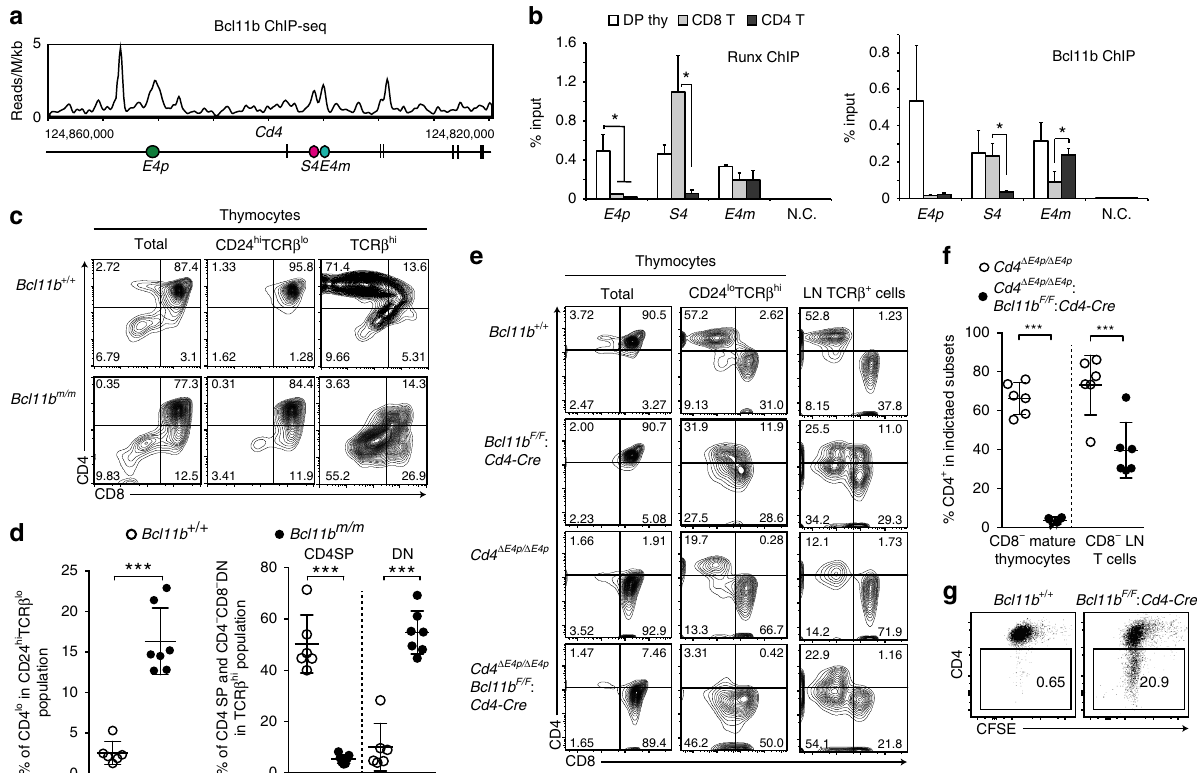
Fig. 4 Requirement for Bcl11b in activating Cd4 at two stages. a ChIP-Seq tracks at the Cd4 gene showing binding of Bcl11b in total thymocytes. b ChIP-qPCR analyses for Runx (left) and Bcl11b (right) bindings to the Cd4 proximal enhancer ( E4p ), Cd4 silencer ( S4 ), and Cd4 maturation enhancer ( E4m ) in DP thymocytes, peripheral CD4 + ,and CD8 + T cells. N.C.: negative control region. Summary of three independent ChIP experiments. Means ± SD. * p < 0.05 (One-way ANOVA and Tukey ’ s multiple comparison test). c Contour plots showing CD4 and CD8 expression in indicated thymocyte subsets of Bcl11b + / + and Bcl11b m/m newborn mice. Numbers in quadrants indicate respective cell percentages. Representative results of at least three independent analyses. d Summary of percentage of indicated cell types in indicated cell populations of Bcl11b + / + and Bcl11b m/m mice. Means ± SD. *** p < 0.001 (unpaired student t test, two-sided). e Contour plots showing CD4 and CD8 expression in indicated thymocyte subsets and lymph node (LN) T cells of mice with indicated genotypes. Numbers in quadrants indicate respective cell percentages. Representative results of at least three independent analyses. f Statistical